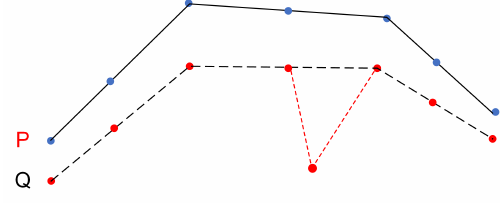
Figure 13. A trajectory with an outlier point.